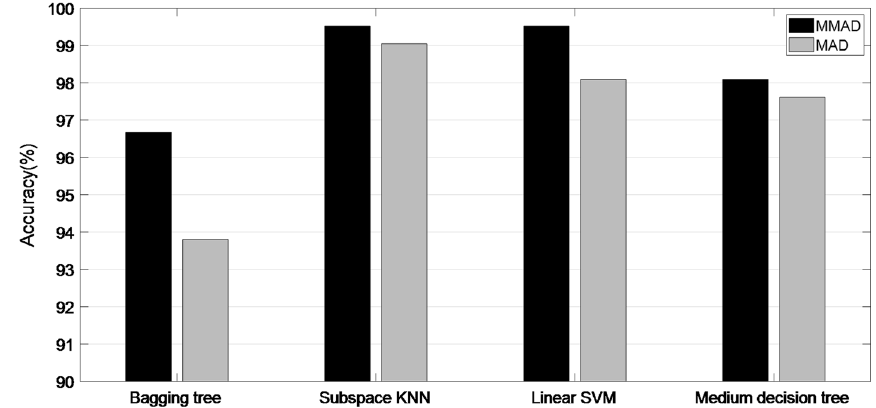
Fig. 9 Performance comparison of MMAD and MAD algorithm